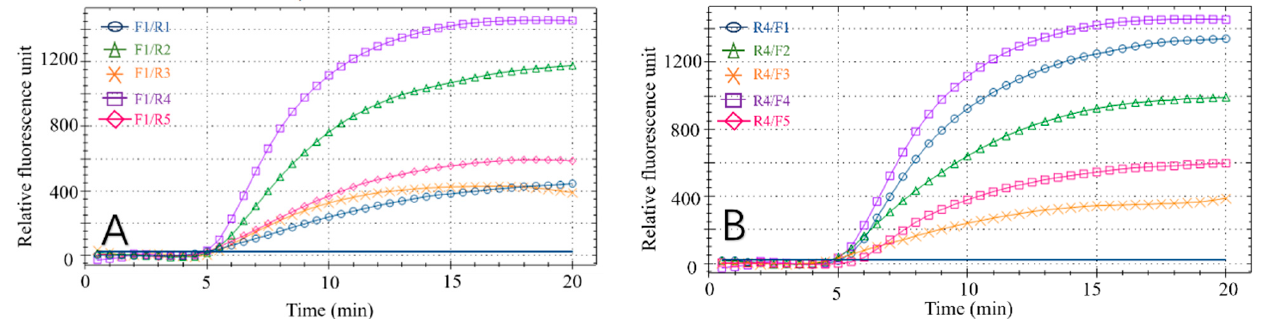
Figure 2. Results of primer screening. ( A ) Amplification results of forwarding primer F1 and all reverse primers. ( B ) Amplification results of reverse primer R4 and all forward primers.